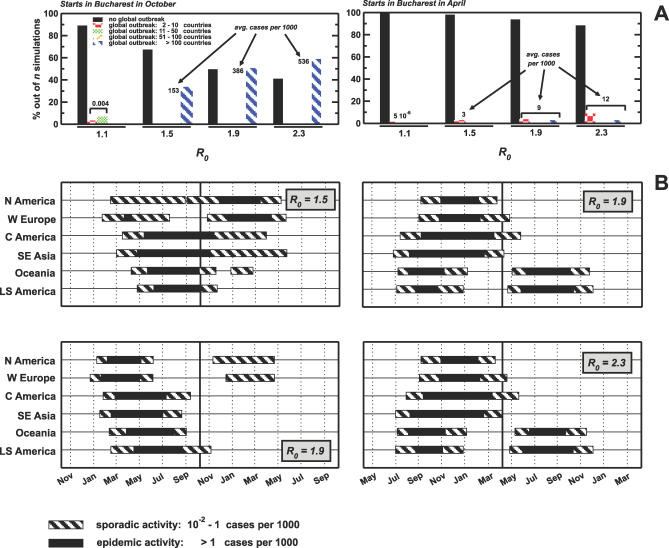
Baseline Scenario: Probability of Global Outbreaks and Expected Evolution for a Pandemic Seeded in Bucharest(A) Probability of observing a global outbreak after one year from the beginning of the epidemic. In the case of outbreaks starting in April, the reproductive rate is effectively reduced to a value smaller than one because of seasonal effects. This effect makes global outbreaks unlikely.(B) Timing of the influenza pandemic in the six regions under study. Results for different values of the reproductive rates are shown: R0 = 1.5 and R0 = 1.9 for a pandemic starting in October, and R0 = 1.9 and R0 = 2.3 for a pandemic starting in April. Results shown refer to the average profiles in each region when a global outbreak affecting more than 100 countries occurs, thus showing a typical timeline of a pandemic when affecting all regions.